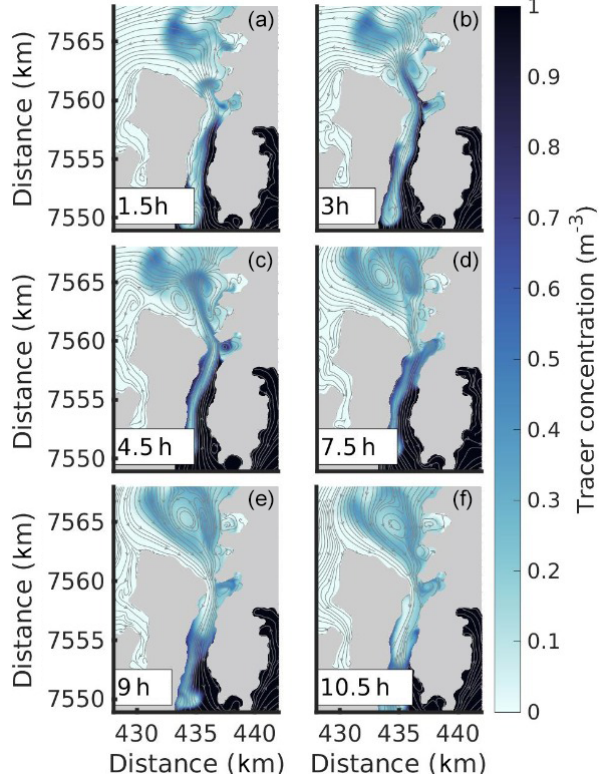
Figure 9. Tracer distribution with corresponding stream-function is displayed for Nappstraumen (4) during the first full tidal cycle in the simulation. The time is given in hours after slack tide after ebb. Panels (a)–(c) are snapshots during northward flow (flood tide), and panels (d) – (f) are snapshots during southward flow (ebb tide).